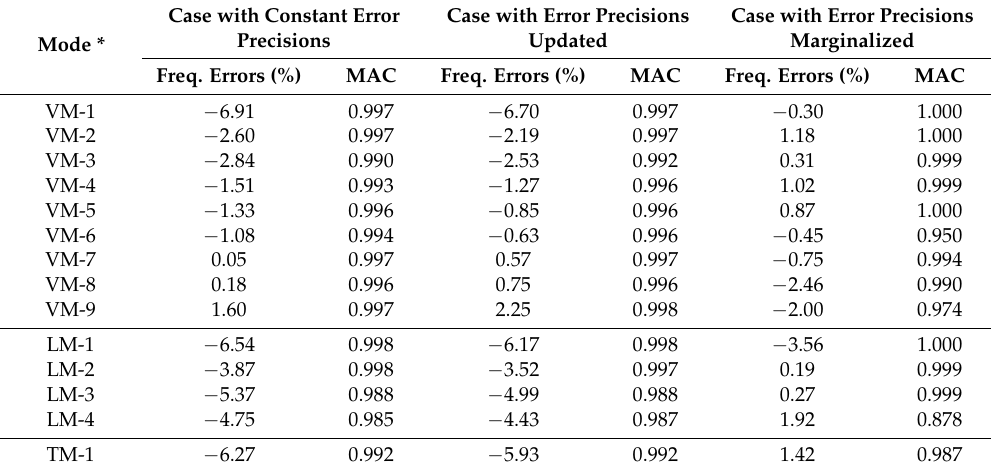
Table 3. Frequency errors and MAC values using the three error